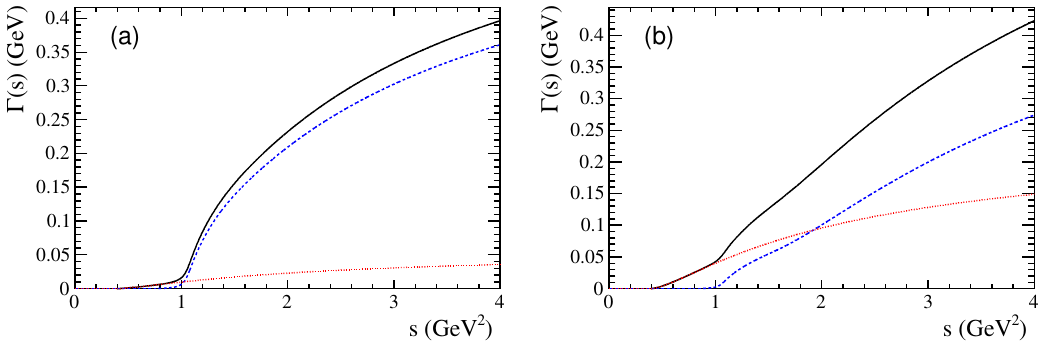
Figure 18 . Energy-dependent width for the K (cid:3) (1410) (a) and K (cid:3) (1680) (b) resonances. The total width is shown in black (solid), while the partial widths into the channels K(cid:25)(cid:25) and K(cid:25) are shown in blue (dashed) and red (dotted),